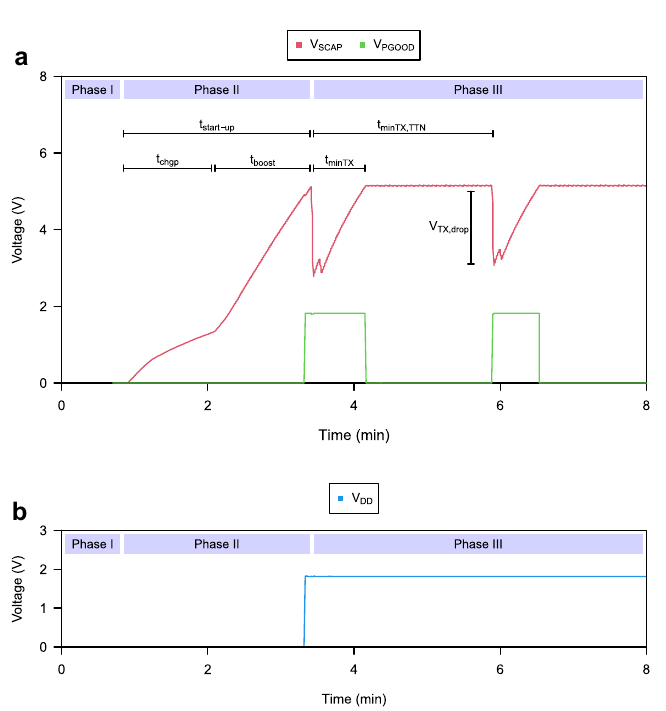
Figure 4. Transient waveforms during the start-up and steady-state operation of the device for a temperature ◦ gradient of 13 C. ( a ) The voltage across the supercapacitor ( V SCAP ), and the signal indicator of the availability of enough energy to perform a transmission ( V PGOOD ). ( b ) The regulated voltage supply ( V DD